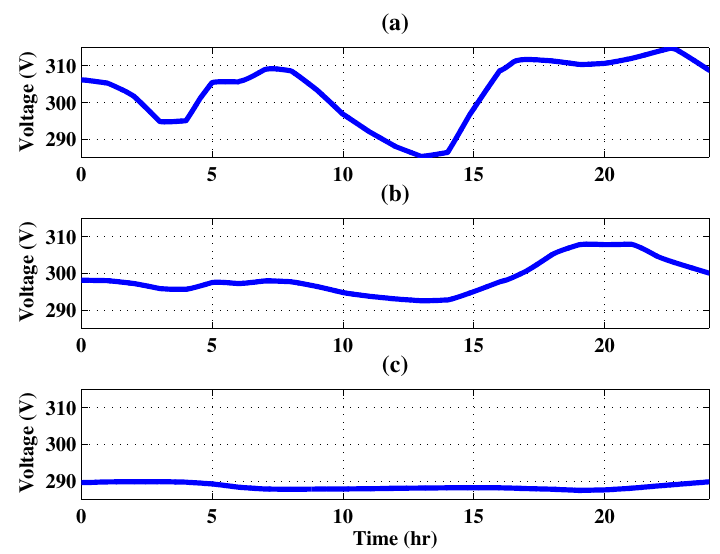
Figure 23. Microgrid bus voltage with ( a ) optimal multidimensional droop control, ( b ) multidimensional droop control and ( c ) traditional droop